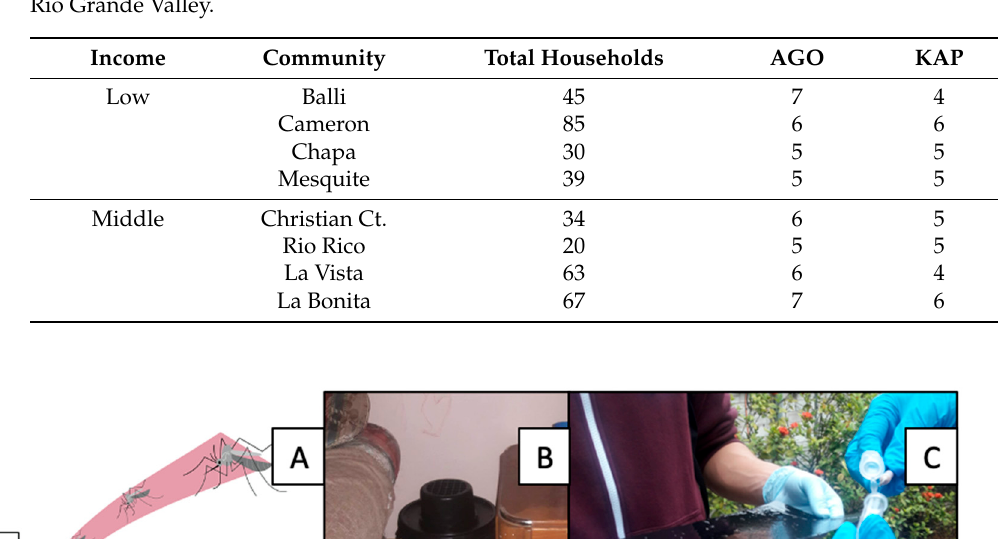
Table 1. Total number of households in the communities and total number of households with